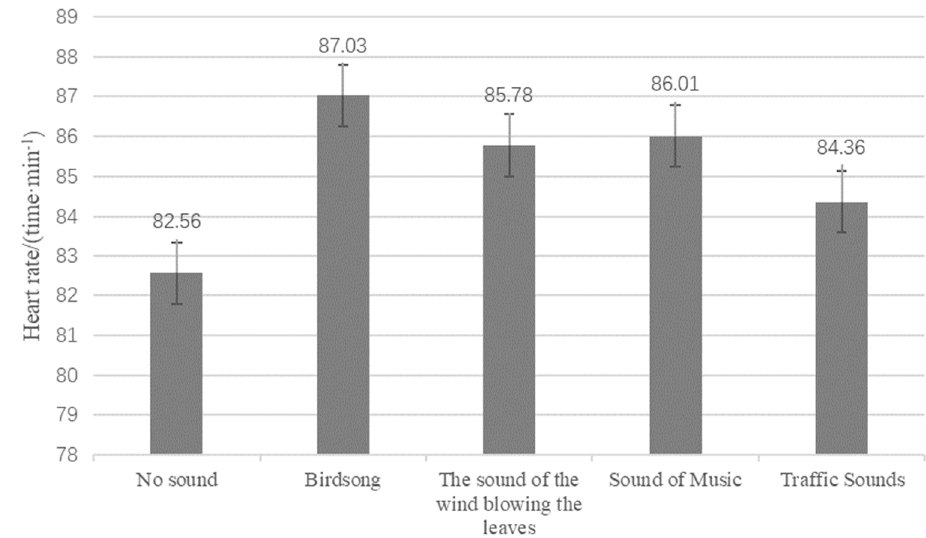
Figure 6. Heart rate changes after different types of sound stimulation.